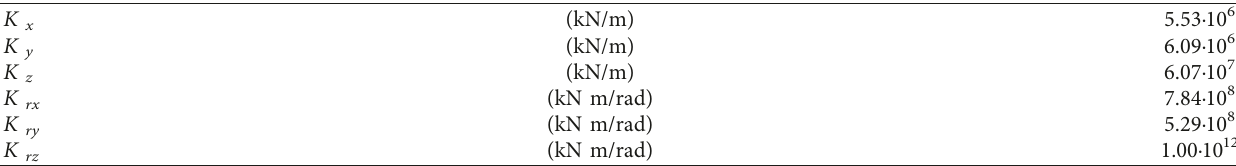
Figure 6: Longitudinal cross-section of the common steel bearings. Table 3: Stiffness values of the soil springs.